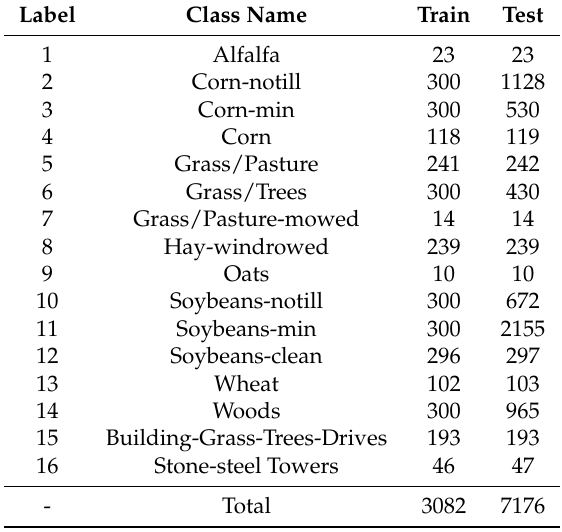
Table 1. The distribution of training and testing samples of the Indian Pines data set.